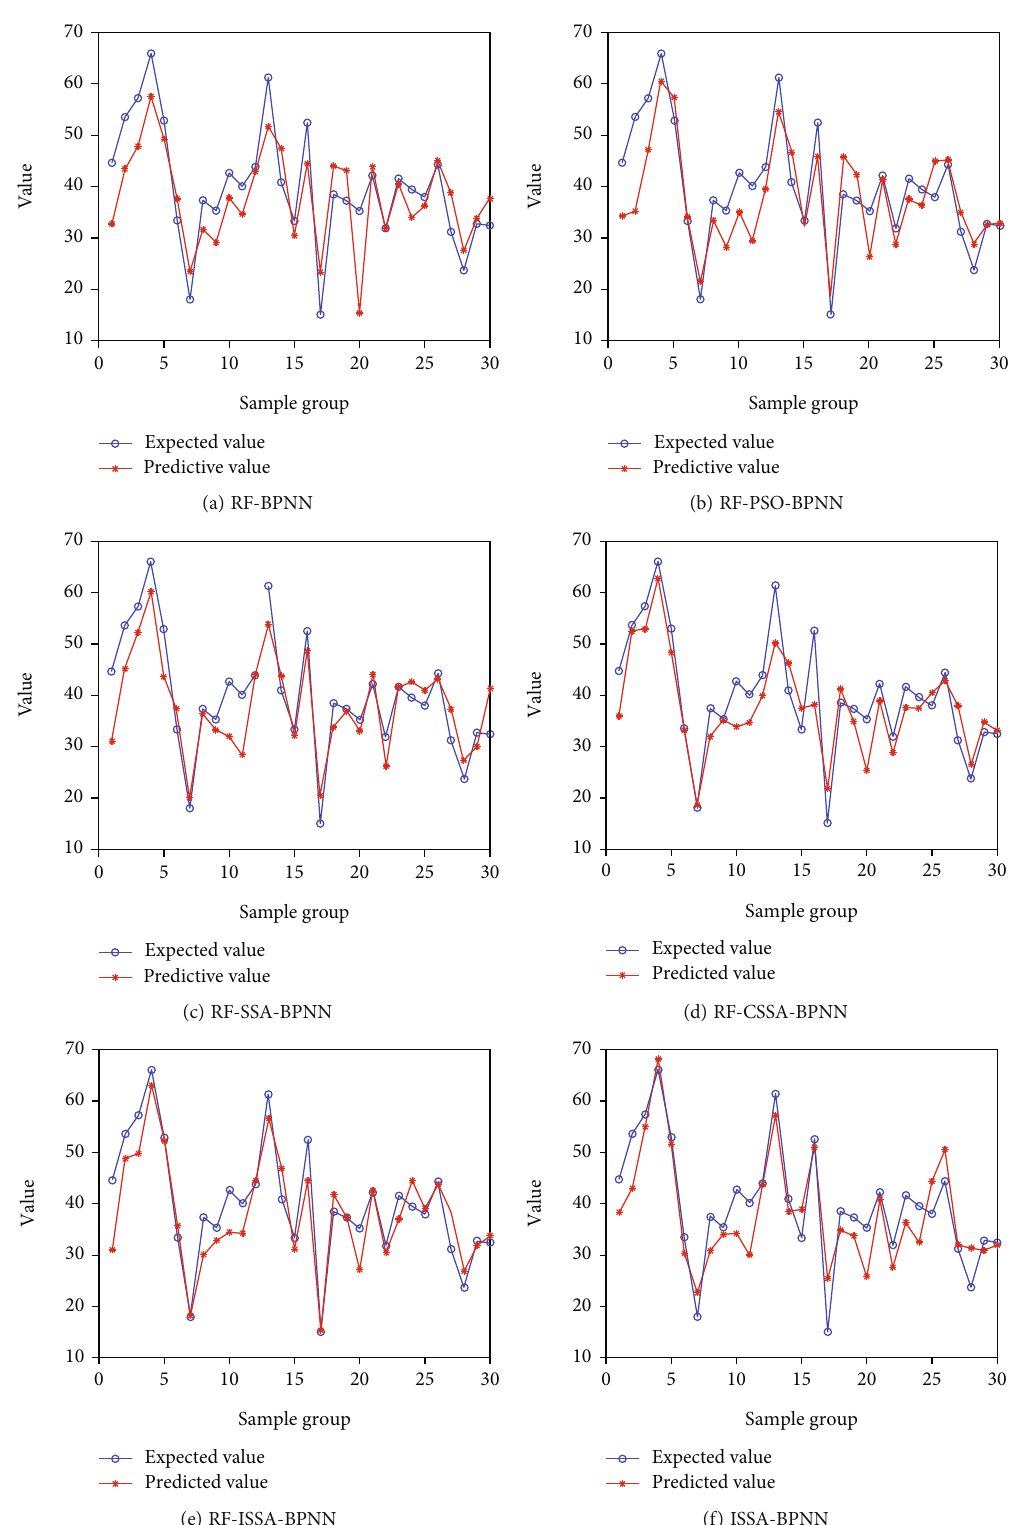
Figure 13: The prediction results of the concrete compressive strength of each